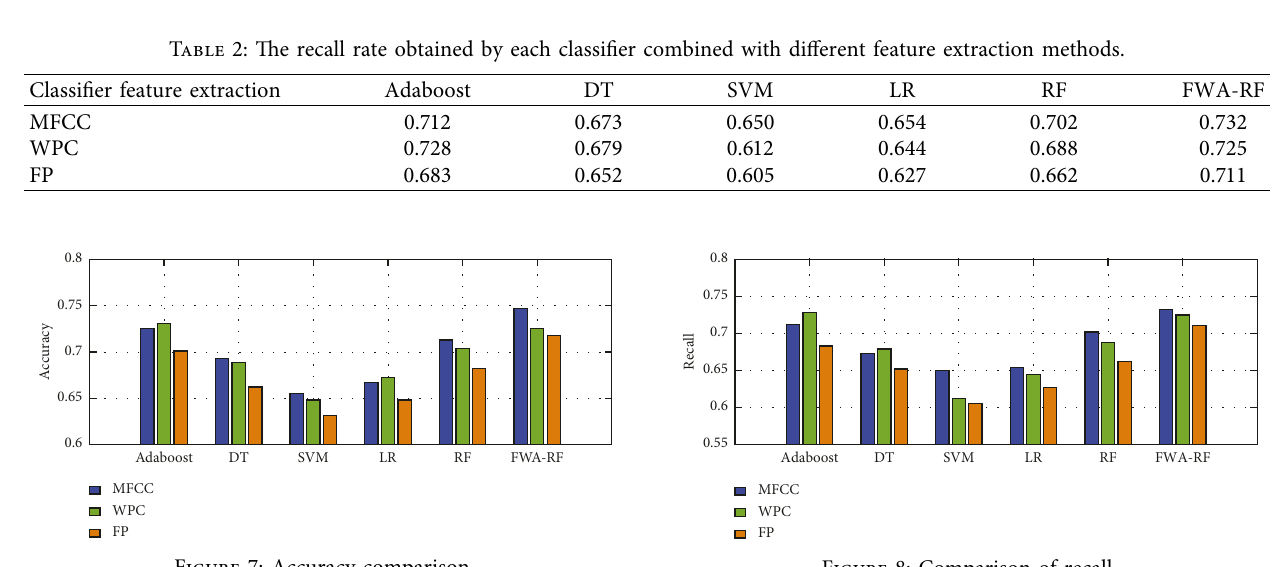
Figure 7: Accuracy comparison.